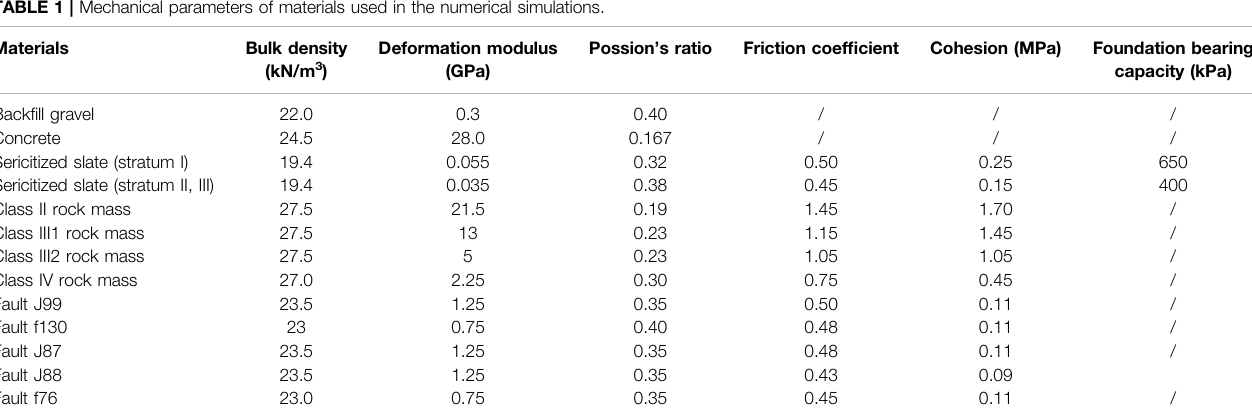
TABLE 1 | Mechanical parameters of materials used in the numerical